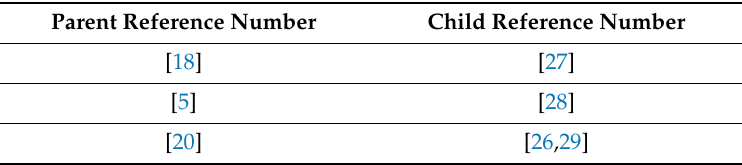
Table 4. Relation between Parent & Child